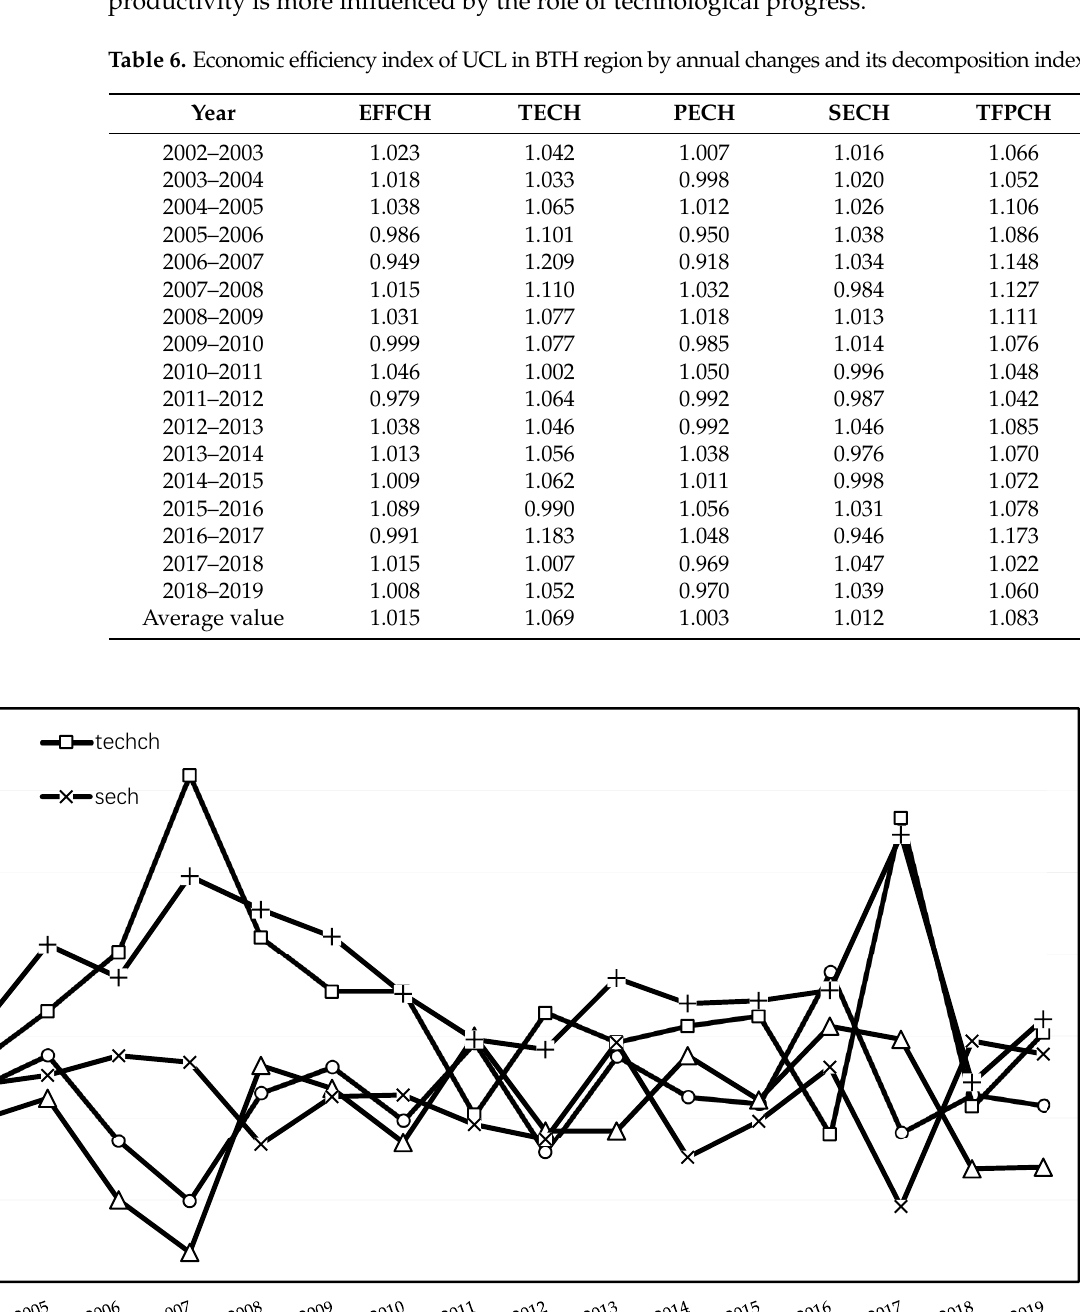
Figure 4. Trends of economic efficiency change index of UCL and its decomposition index in the BTH urban agglomeration from 2002 to 2019. Table 6. Economic efficiency index of UCL in BTH region by annual changes and its decomposition index.